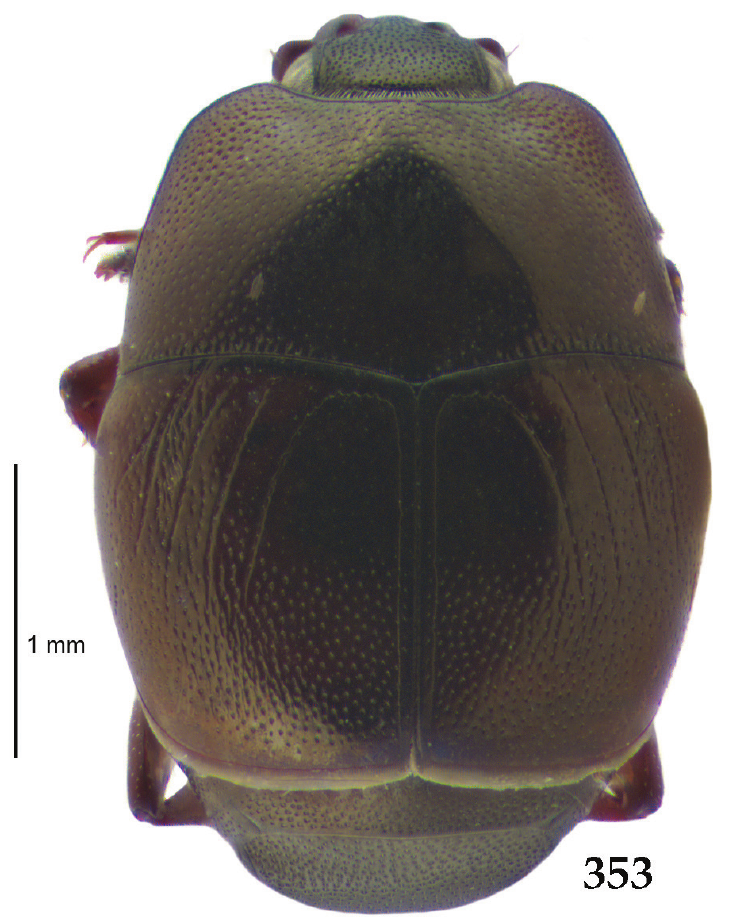
Figure 353. Saprinus ( Saprinus ) chalcites (Illiger, 1807) habitus, dorsal